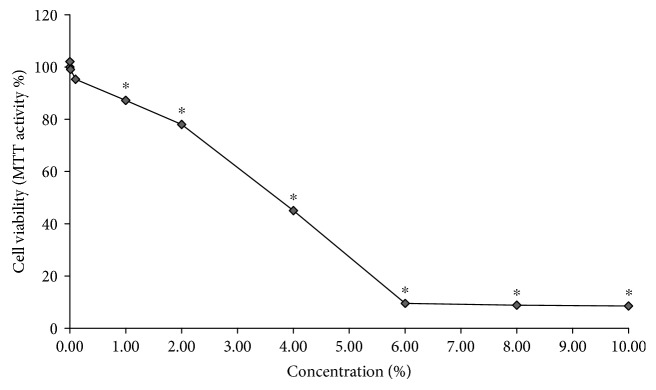
HUVEC viability after treatment with 0.001%-10.00% TH for 24 h. Data were generated from three independent experiments and expressed as the mean ± SEM where ∗p < 0.05 is considered significant versus the no treatment control.